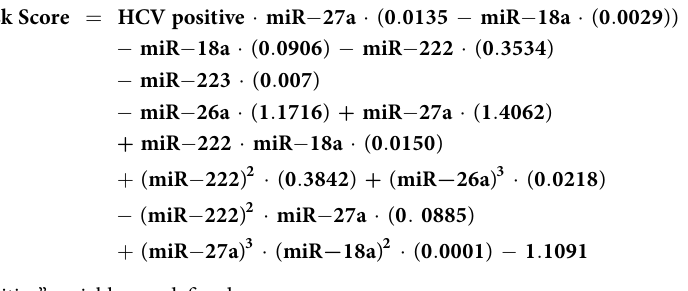
where the “HCV positive” variable was defined as = − − HCV positive {1, 0 1: anti HCV antibody positive; 0: anti HCV antibody negative} By introducing the “HCV positive” variable, this model could be applied to both HBV- and HCV-related cirrhotic patients. Using the optimum cut-off determined by Youden’s J statistics to predict HCC occurrence, the sensitivity was 66.67%, the specificity was 77.88%, the positive predictive value was 27.72%, and the negative pre- dictive value was 94.83%. The constant term of the model equation was calibrated to enable a zero median value in the cirrhosis patient group (N = 330).